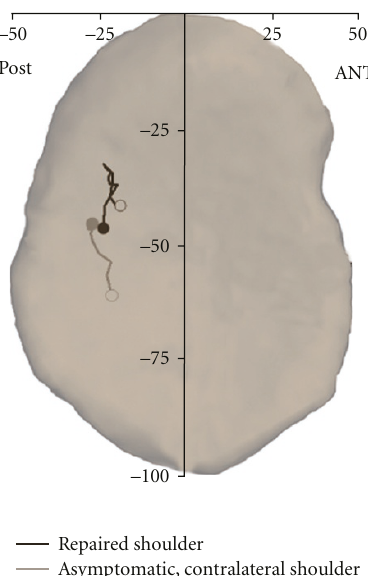
Figure 3: Average path of the glenohumeral joint contact center (superimposed on a typical glenoid) during coronal-plane abduc- tion. For each path, the open circle ( ◦ ) indicates the starting position and the closed circle ( • ) indicates the ending position. ANT: anterior, POST: